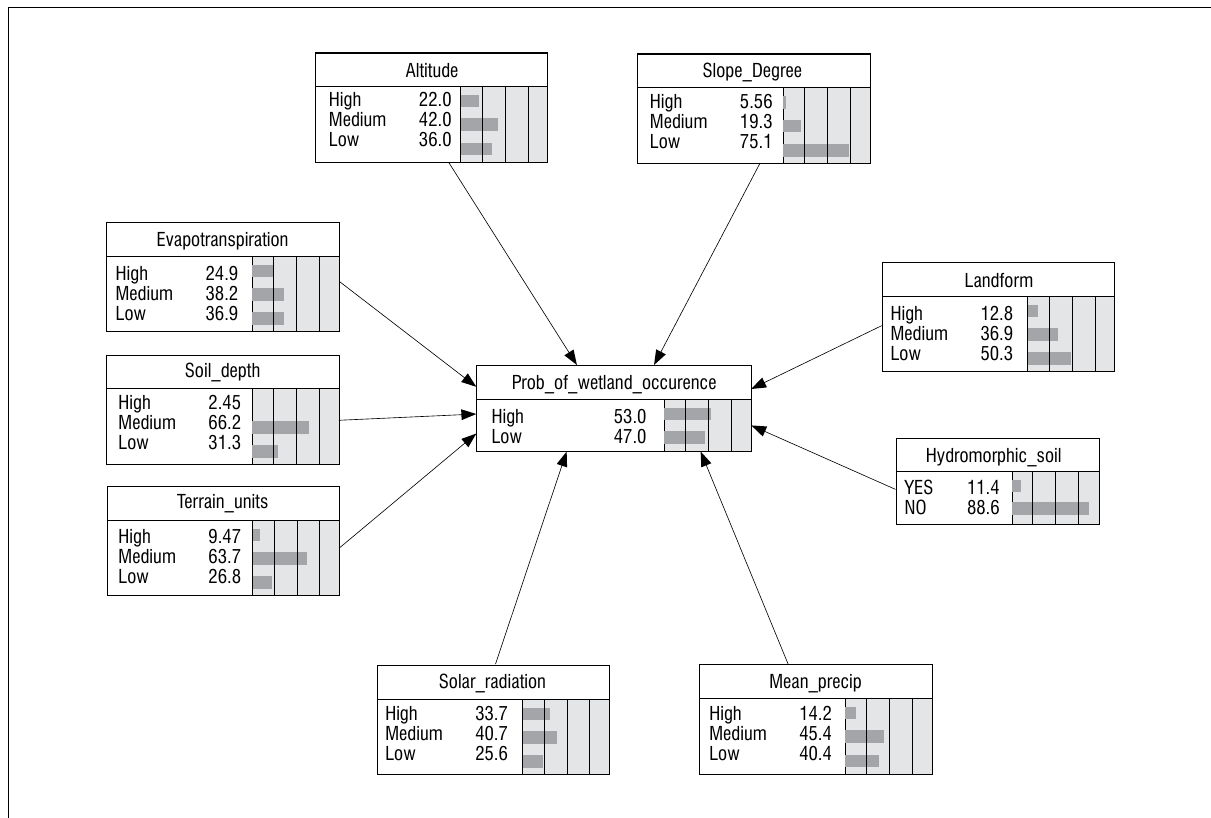
Figure 3: Diagram illustrating the Bayesian network structure used in calculating the conditional probabilities. The outer parent nodes are the remaining input variables and the child node is the ‘probability of wetland